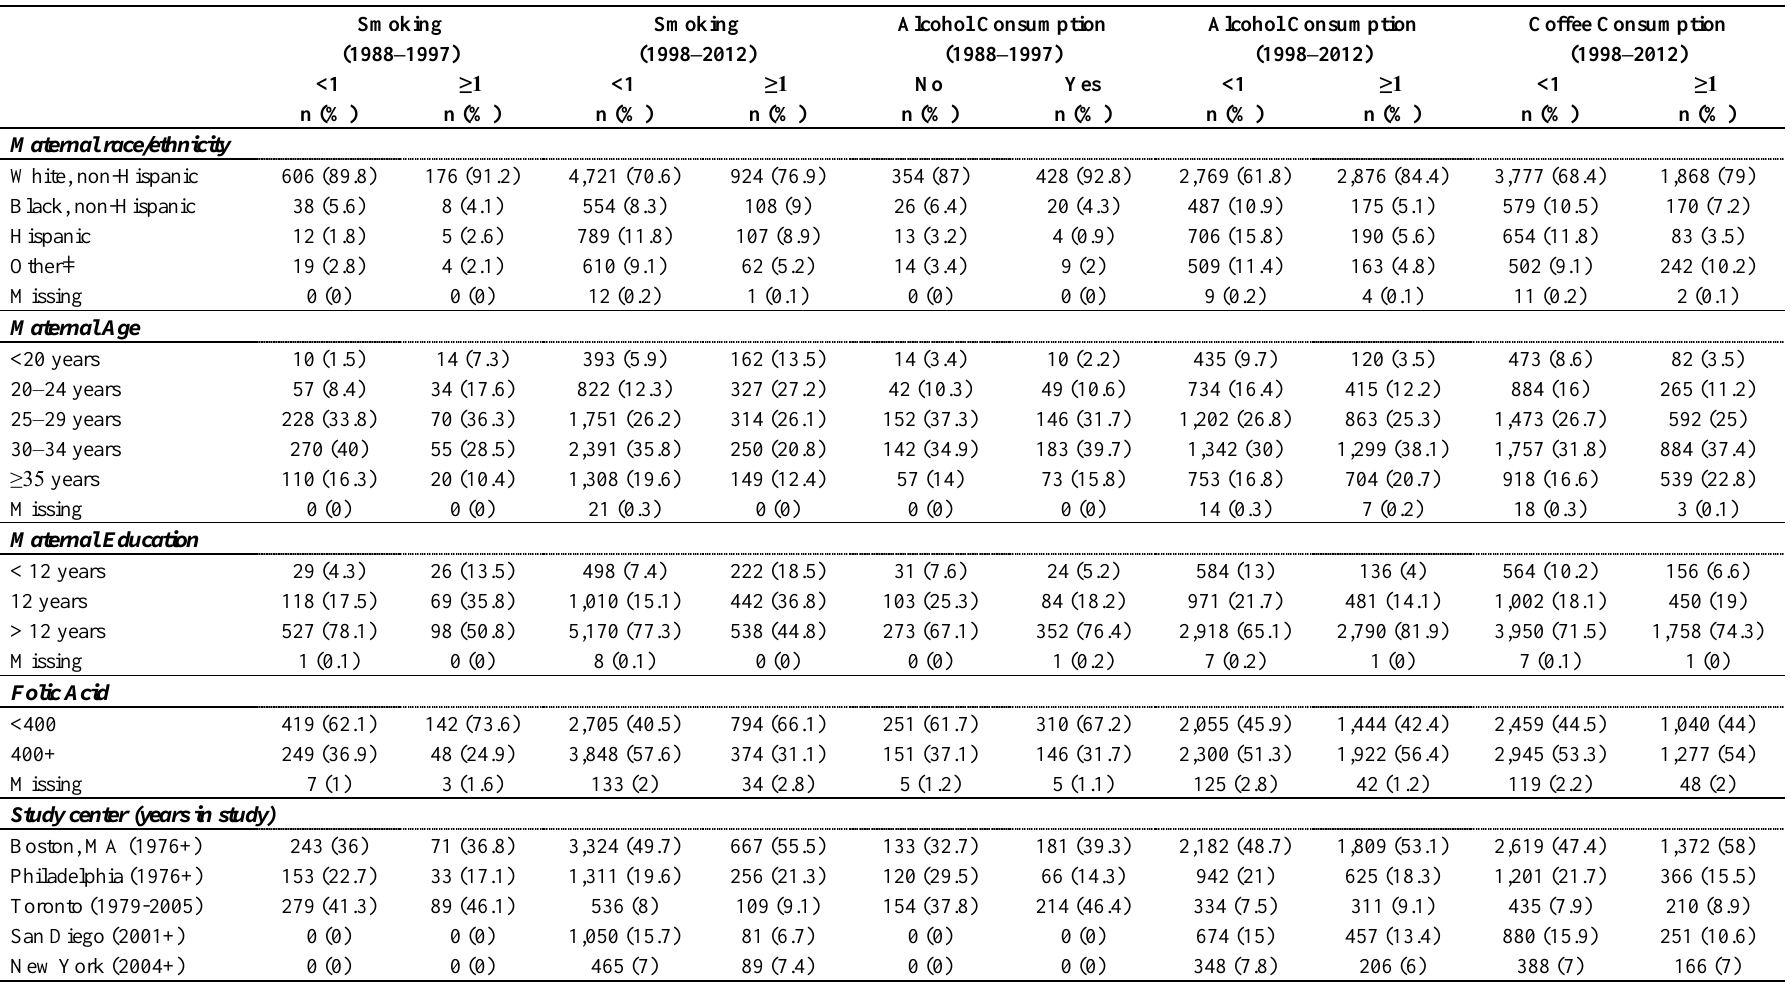
Table 2. Maternal Demographics According to Control Subject’s Exposure During the First Month of Pregnancy, Birth Defects Study,